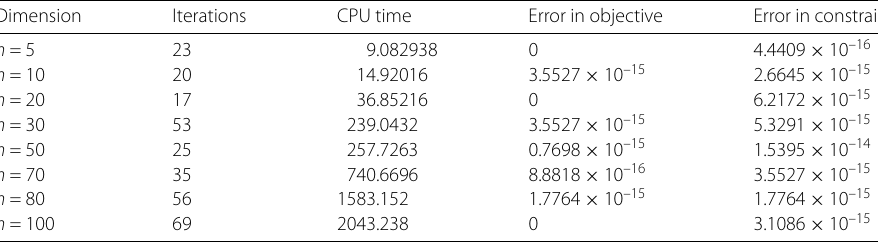
Table 4 Computational results of random Example